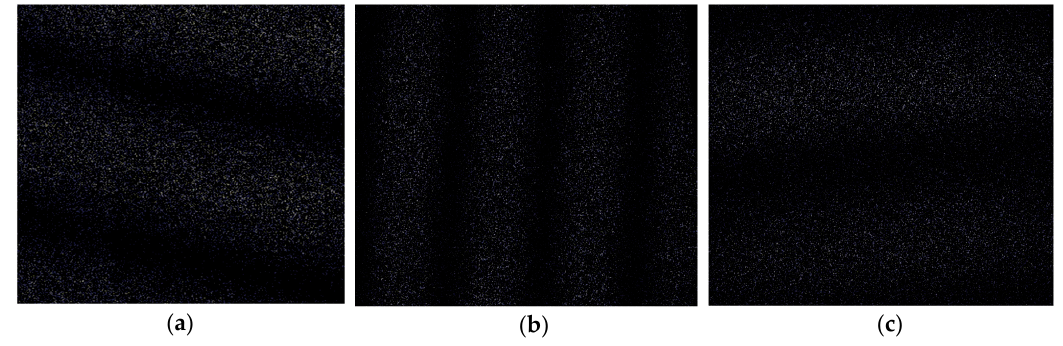
Figure 10. The speckle pattern interferometry fringes: ( a ) the grey-scale map of fringes in the z -direction; ( b ) the grey-scale map of fringes in the y -direction; and ( c ) the grey-scale map of fringes in the x -direction.